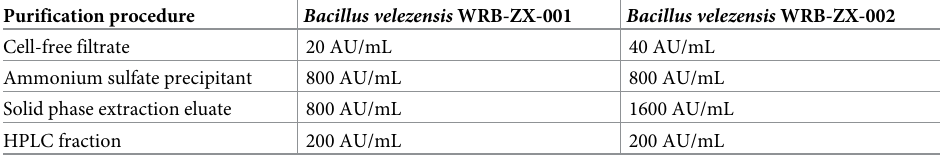
Table 2. Antifungal activity of purification products of Bacillus velezensis isolates against food-isolated Aspergil- lus fumigatus .